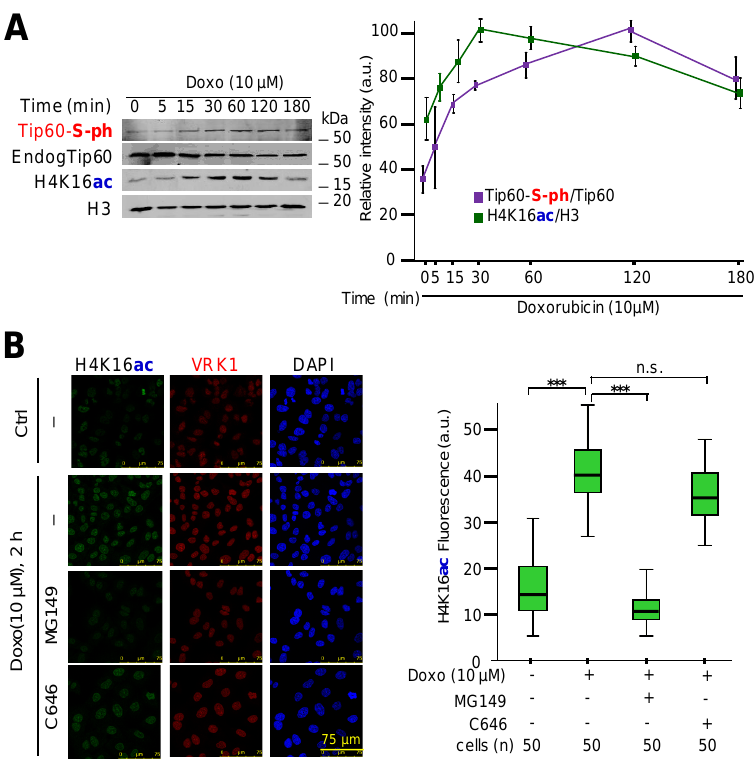
Figure 1. E ff ect of KAT (Lysine acetyl transferase) inhibitors on the acetylation of histone H4 induced by doxorubicin. ( A ). Time course of the e ff ect of doxorubicin on the phosphorylation of endogenous